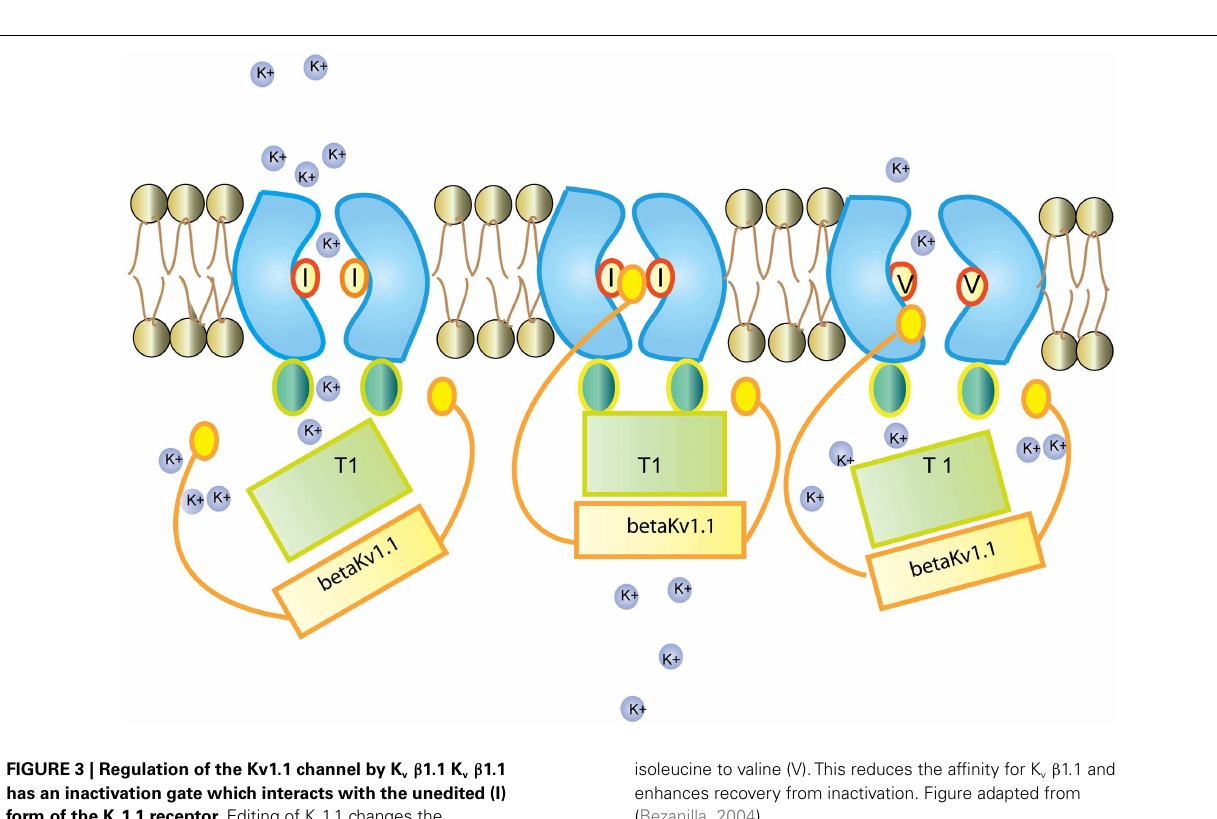
FIGURE 2 |Topography of the neuronal channels containing editing sites Ionotropic glutamate receptor, GABA A receptor subunit α 3, Kv1.1, Cav1.3, and 5-HT 2c receptors are shown. The relative position of the editing sites within these receptors are highlighted. Consequences of editing are indicated.